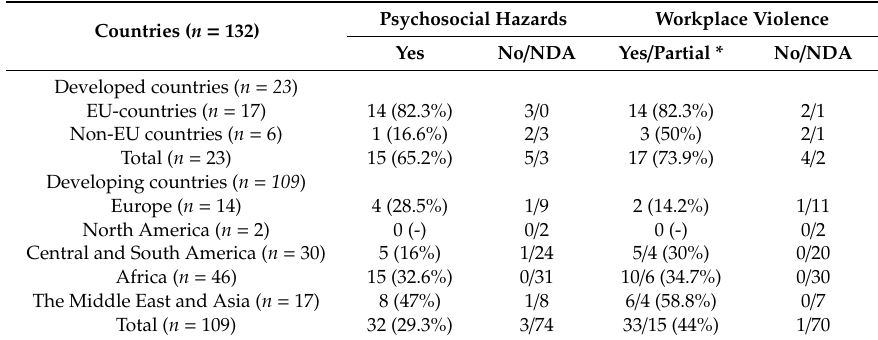
Table 1. Characteristics of occupational safety and health (OSH) legislation about psychosocial hazards and workplace violence in developed and developing countries. Psychosocial Hazards Workplace Violence Countries ( n = 132) Yes No / NDA Yes / Partial * No / NDA Developed countries ( n = 23 ) EU-countries ( n = 17) 14 (82.3%) 3 / 0 14 (82.3%) 2 / 1 Non-EU countries ( n = 6) 1 (16.6%) 2 / 3 3 (50%) 2 / 1 Total ( n = 23) 15 (65.2%) 5 / 3 17 (73.9%) 4 / 2 Developing countries ( n = 109 ) Europe ( n = 14) 4 (28.5%) 1 / 9 2 (14.2%) 1 / 11 North America ( n = 2) 0 (-) 0 / 2 0 (-) 0 / 2 Central and South America ( n = 30) 5 (16%) 1 / 24 5 / 4 (30%) 0 / 20 Africa ( n = 46) 15 (32.6%) 0 / 31 10 / 6 (34.7%) 0 / 30 The Middle East and Asia ( n = 17) 8 (47%) 1 / 8 6 / 4 (58.8%) 0 / 7 Total ( n = 109) 32 (29.3%) 3 / 74 33 / 15 (44%) 1 /